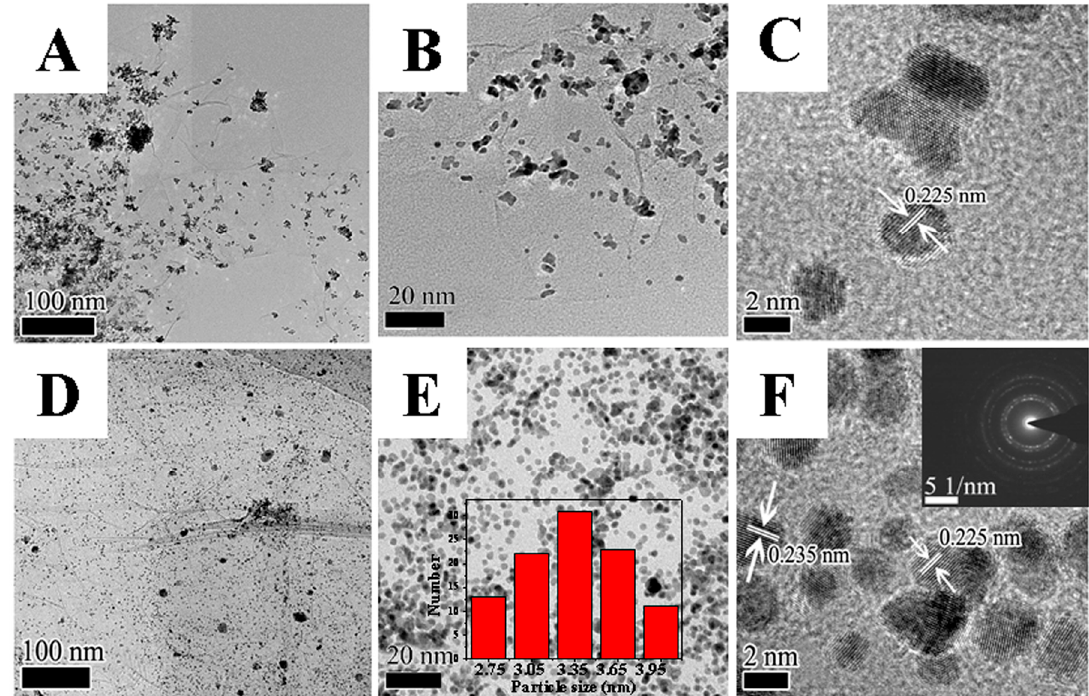
Figure 2. Transmission electron microscopy (TEM) and high ‐ resolution TEM (HRTEM) images of Pt/GNs ( A , B , C ) and Pt ‐ Ag/GNs ( D , E , F ); particle size distributions of Pt ‐ Ag/GNs in the inset of ( E ); SAED of Pt ‐ Ag/GNs in the inset of ( F ).